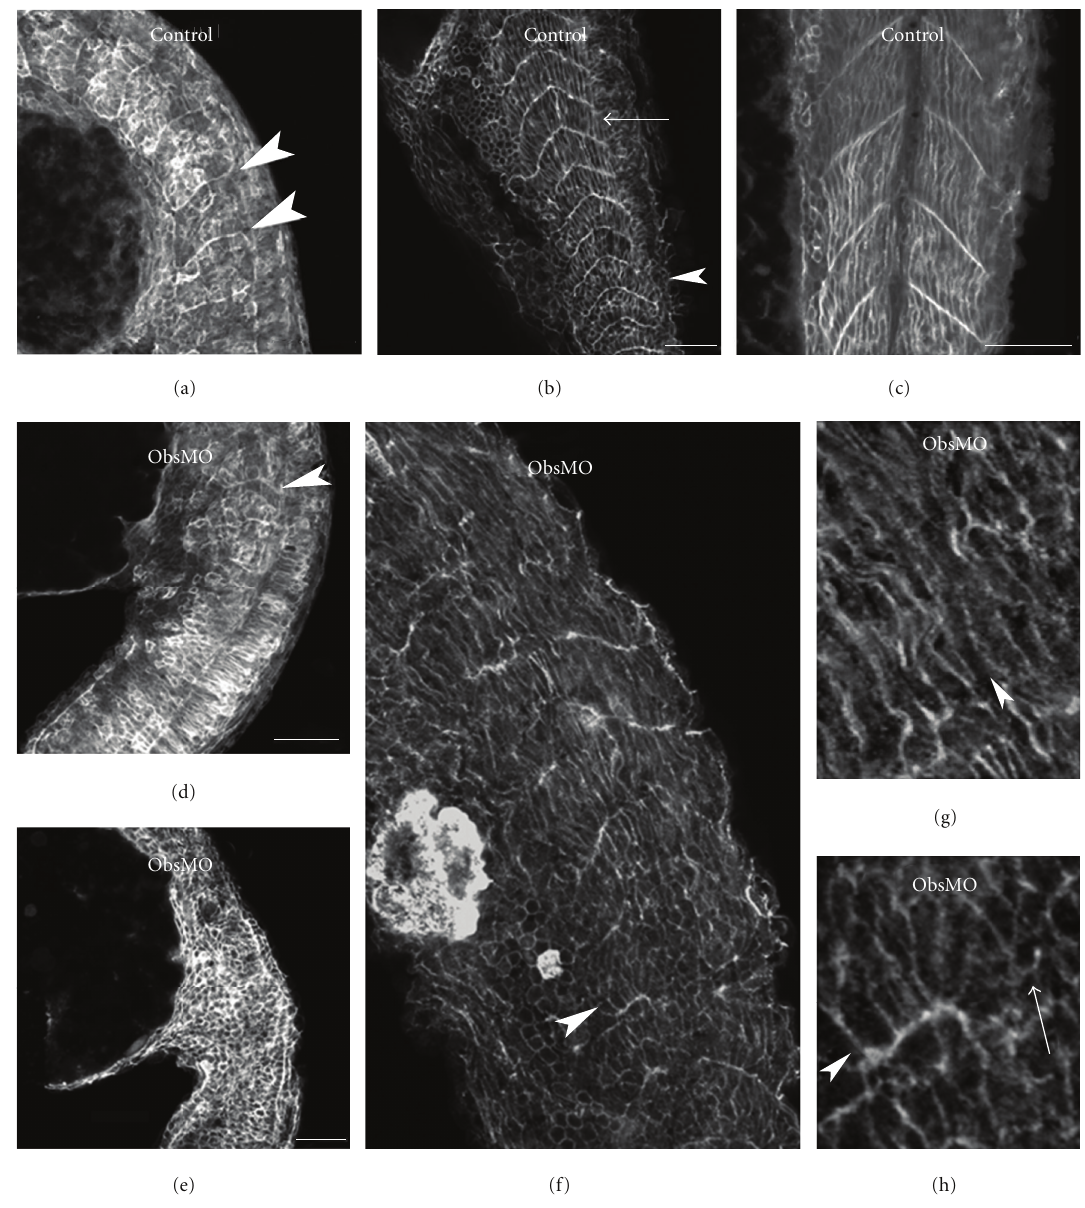
Figure 2: Obscurin A depletion results in abnormalities in the tissue architecture of skeletal muscle. Control (a)–(c) and obscurin A morphant (d)–(h) embryos were injected with a mRNA encoding for lyn-GFP and fixed at 18 (a), (d), (g), 24 (b), (e)–(h), and 48 (c) hpf. (a) Lyn is incorporated into the membrane and accumulates along the somite boundaries as they form (arrowheads). (b) As the myocytes mature, they transition from rounded morphology (arrowhead) and elongate (arrow) to span the length of the developing myotome to insert into the ECM at the MTJ. (c) By 48hpf, all the fast-twitch skeletal myocytes have elongated. (d) In response to obscurin depletion, only rare somite boundaries (arrowhead) were noted. (e) In a more severely a ff ected obscurin morphant embryo, no nascent somite boundaries are detected and the myoblasts remain rounded. (f) As development proceeds in a mildly a ff ected obscurin morphant embryo, patchy development of nascent MTJs reveals a close relationship between apical lyn accumulation and cell elongation (arrowhead). (g) In the more mature somites, myocyte elongation proceeds in the absence of apical lyn clustering (arrowheads). (h) In a younger somite, myoblast elongation (arrowhead) preferentially occurs at the site of apical lyn clustering while other cells remain rounded (arrow). Scale bars are 50 μ m (a)–(f) and 10 μ m (g),